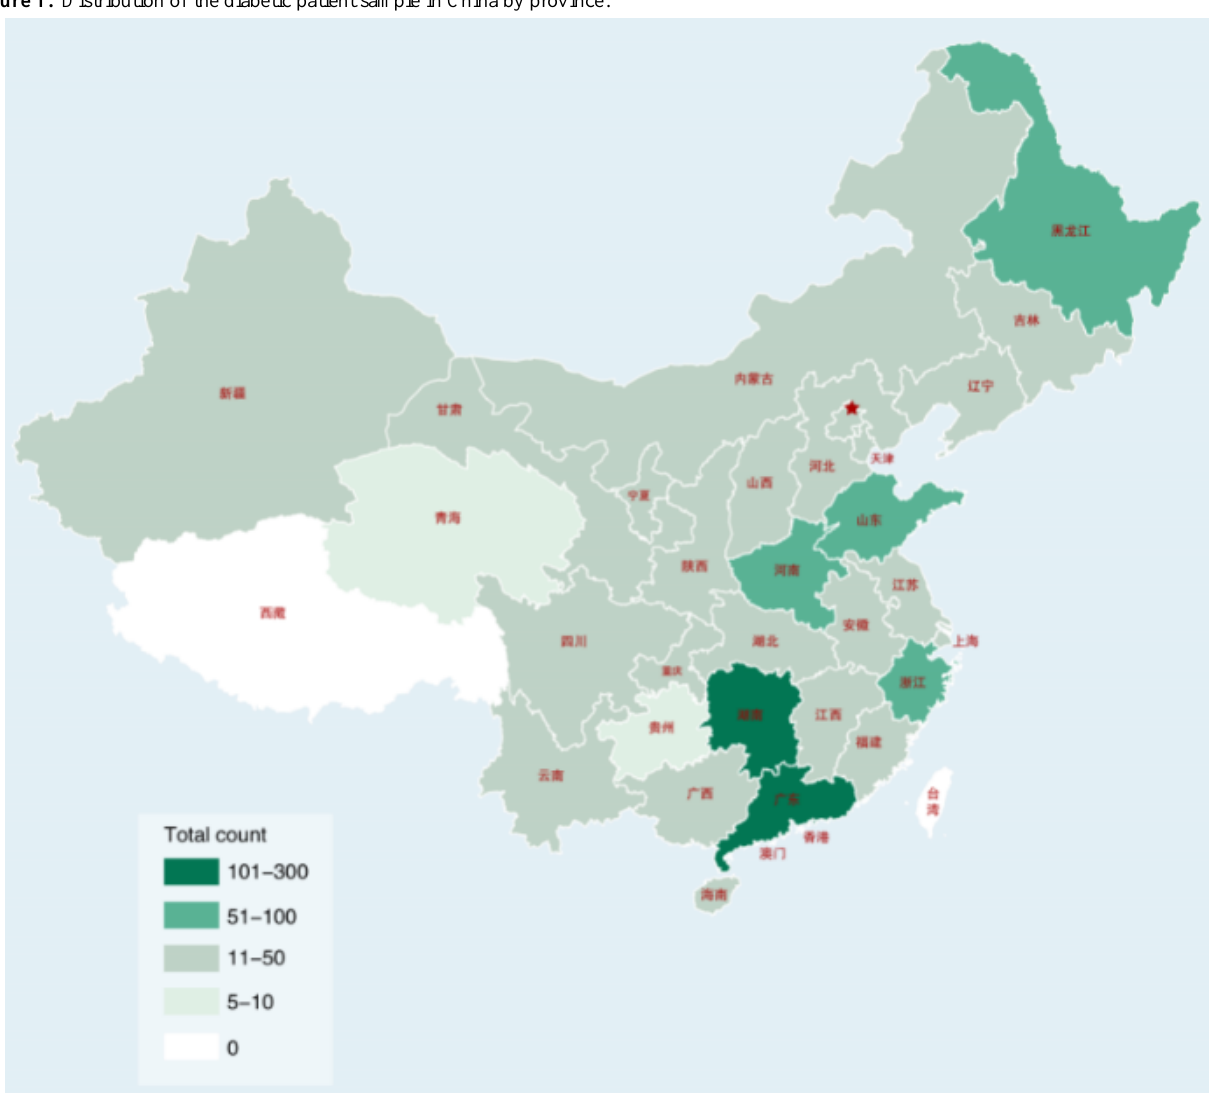
Figure 1. Distribution of the diabetic patient sample in China by